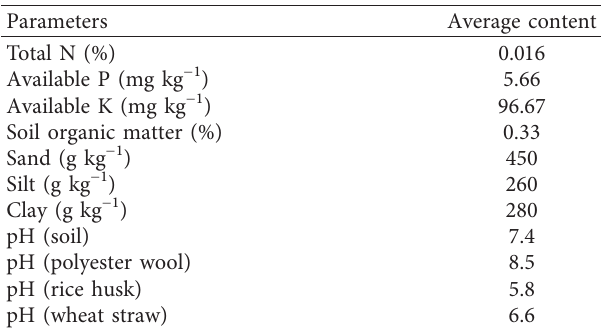
Table 1: Physicochemical properties of soil before planting strawberry runners and pH of different growth